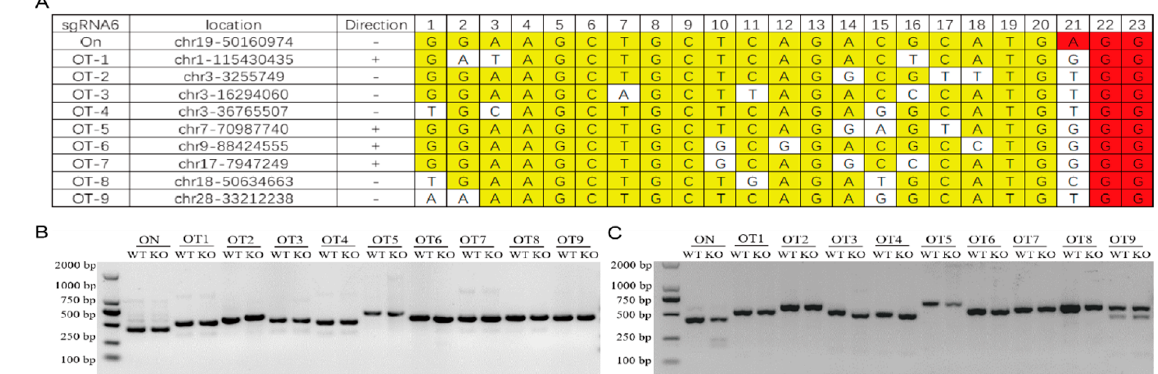
Figure 4. Off-target detection. ( A ) High-probability targeting site information of sgRNA 6 sequence in goat genome. “OT”—off-target site; the yellow highlight represents a coincident target sequence; the red highlight represents a coincident PAM sequence. ( B ) Target site amplification. “ON”—target site; “OT”—off-target site; “WT”—wild-type; “KO”—knockout. ( C ) Enzyme digestion detection of off-target site.